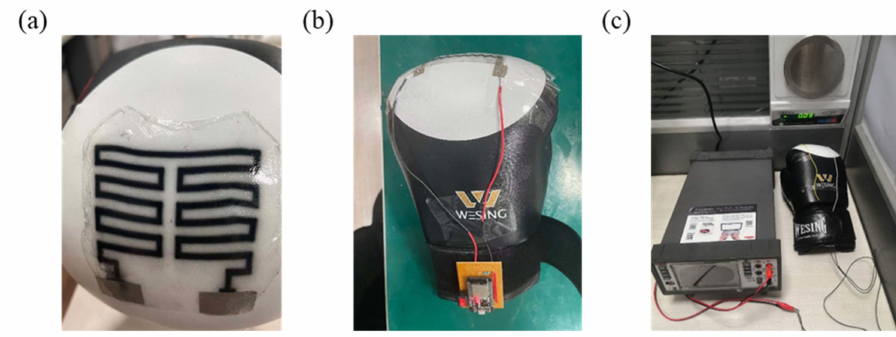
Figure 7. ( a ) Flexible sensor path; ( b ) image of the prototype; ( c ) the testing platform.